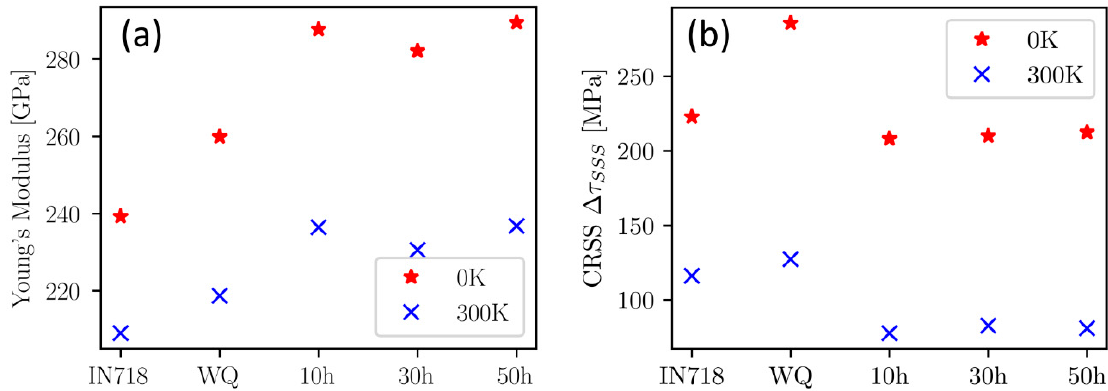
Figure 10. Comparison of calculated materials properties for the matrix composition of IN718 from literature ([20]) and the matrix phase of the actual CCA right after water quenching (WQ) and after 10 h, 30 h, and 50 h of aging at 0 K and 300 K. ( a ) Shows Young’s modulus and ( b ) the critical resolved shear stress (CRSS) [33].